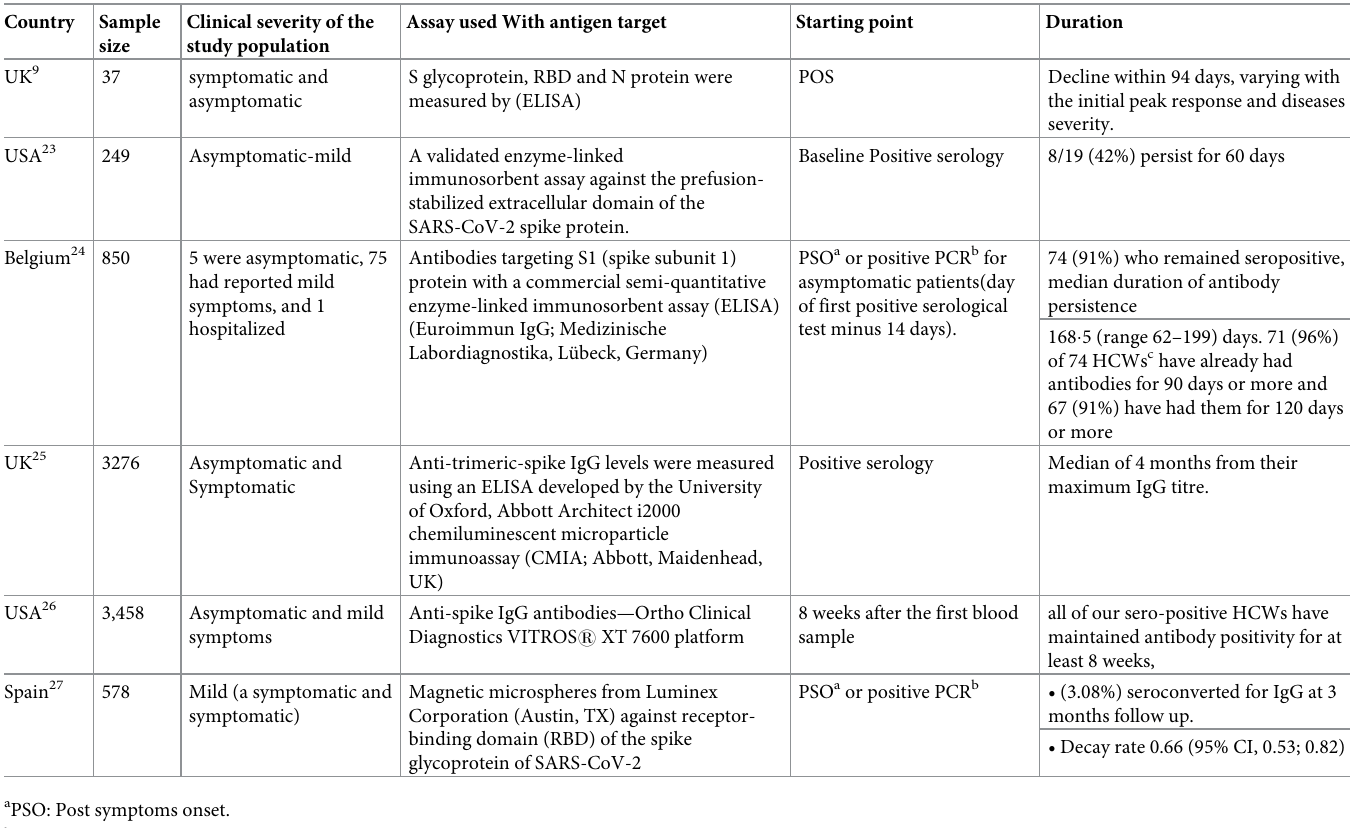
Table 6. Summary of some important longitudinal SARS-CoV-2 IG studies among Health Care Workers. Country Sample size